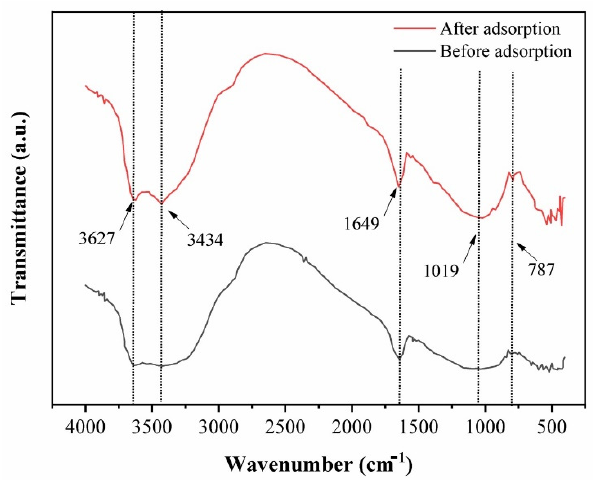
Figure 2. FT-IR spectra of CCB before and after adsorption with Pb(II).